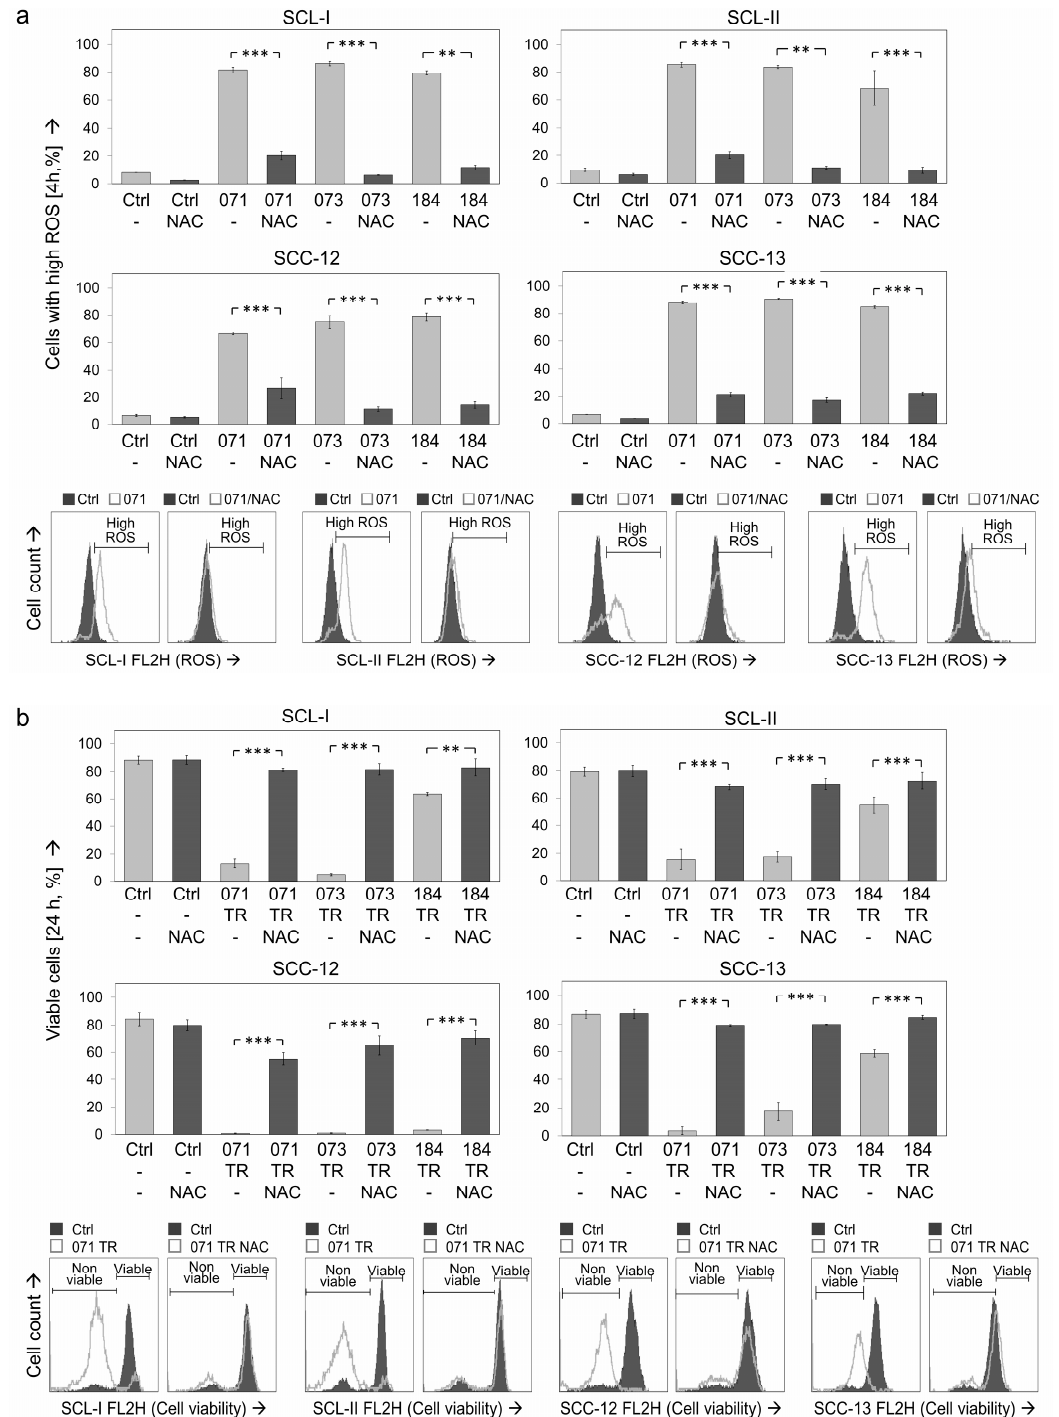
Figure 7. Antagonistic effects of NAC on ROS production and cell viability. The antagonistic effects of the antioxidant N-acetylcysteine (NAC, 1 mM, 1 h pretreatment) were investigated. ( a ) ROS production, as determined by H 2 DCF-DA staining, is shown in the four cSCC cell lines at 4 h of treatment with indirubins (DKP-071, -073 and -184, 10 µ M). ( b ) Cell viability was determined by calcein staining in cell lines at 24 h in response to the combinations of indirubins (DKP-071, -073 and -184, 10 µ M) and TRAIL (TR; 50 ng/mL). ( a , b ) Examples of flow cytometry measurements are provided below (overlays of treated cells vs. controls). Bar charts, mean values and SDs are shown of a representative experiment (two independent experiments, each one with triplicates). Asterisks indicate statistical significance, when cells ± NAC were compared (** p < 0.01; *** p <